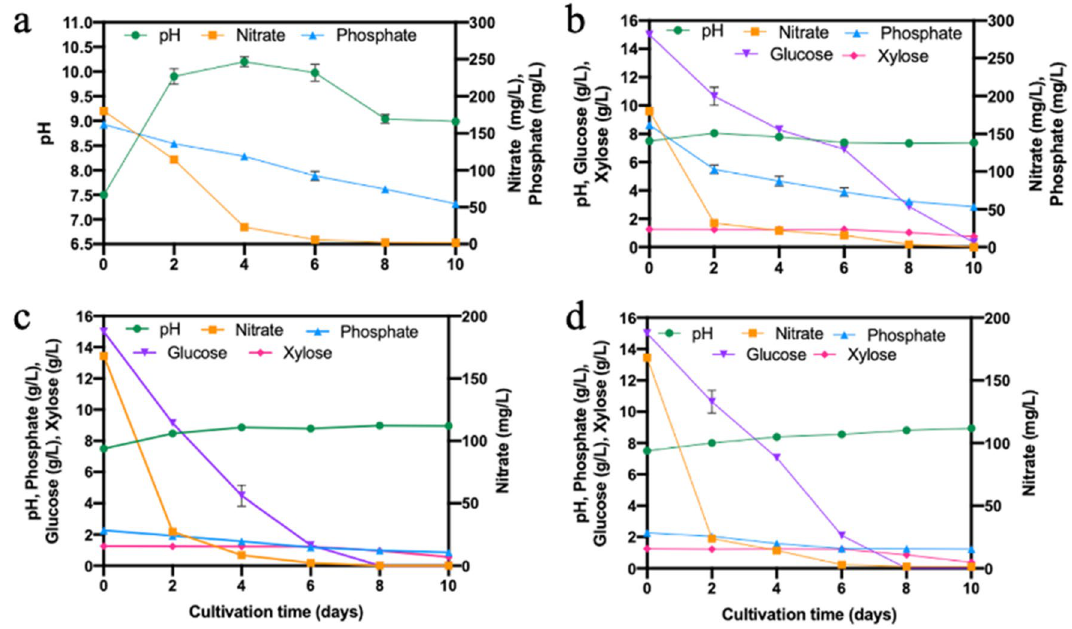
Figure 4. Temporal changes in pH, nitrate, phosphate, glucose, and xylose concentration of the culture media of Chlorella 395 cultivated ( a ) autotrophically; ( b ) mixotrophically in pure sugars; (c) mixotrophically in SSB hydrolysate; and (d) heterotrophically in SSB